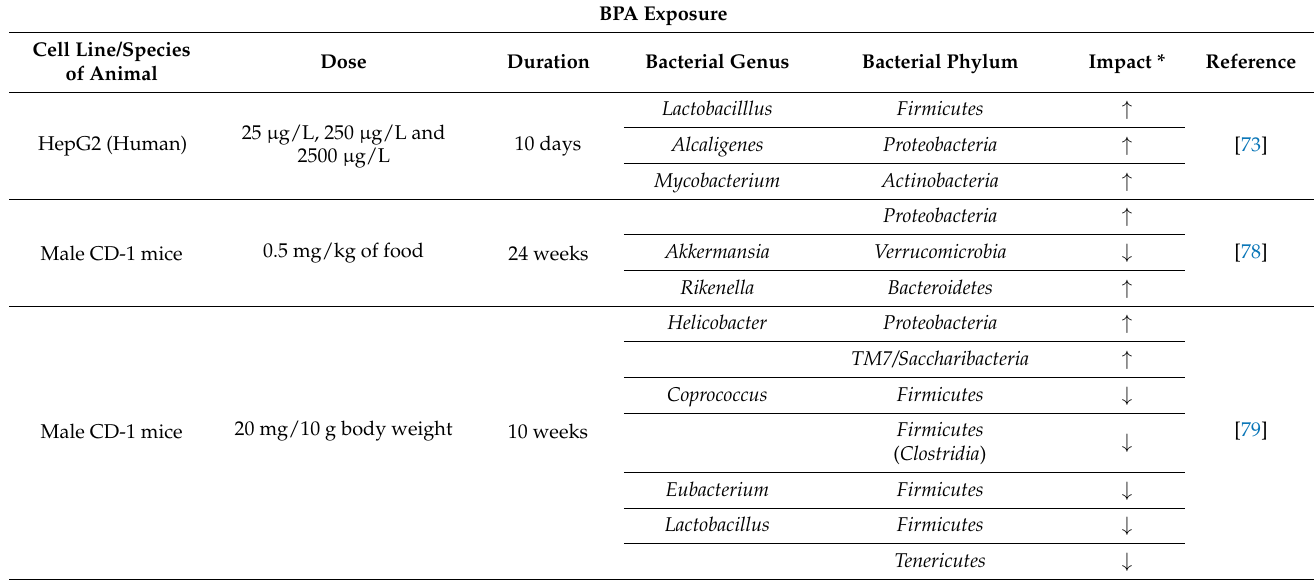
Table 1. Studies on exposure to BPA and its relationship with the intestinal microbiota. BPA